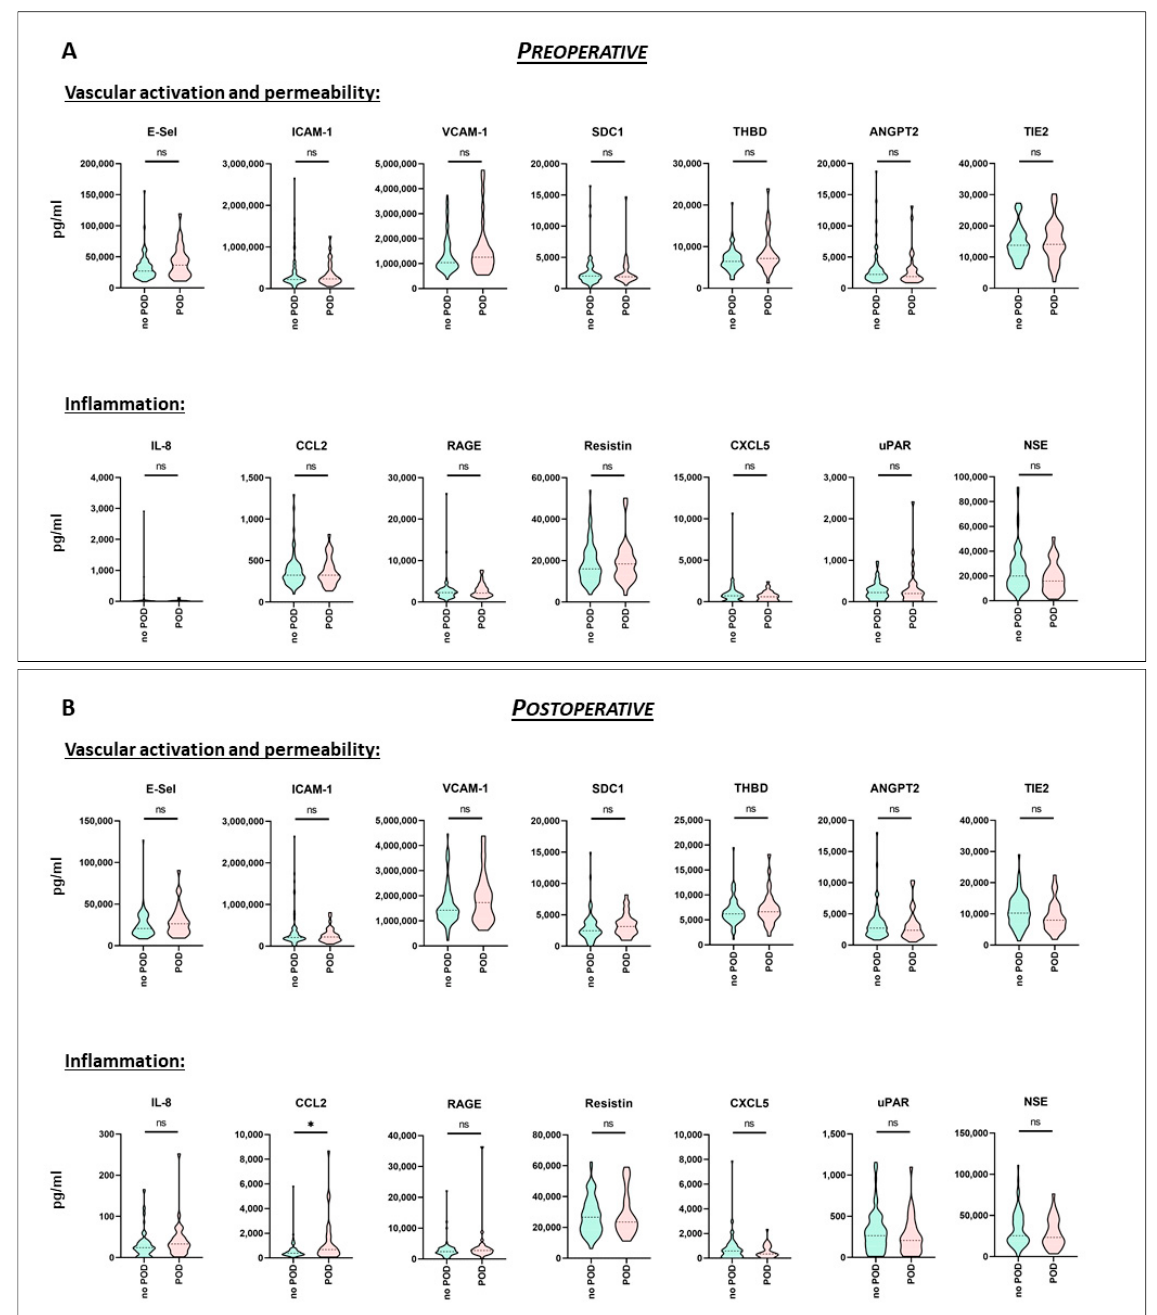
Figure 2. Pre- and postoperative serum biomarker profiling (no-POD and POD). Serum was sampled prior to ( A ) and following surgery ( B ) from a mixed cohort of consecutively recruited elective non-cardiac, as well as cardiac surgery patients. Biomarker profiling was performed using the multiplex array technique. The whole cohort was divided according to development of postoperative delirium (POD). Data are given as median values (black dashed line) with 25th and 75th percentile (white dashed lines) and were compared using the Mann-Whitney U test. no POD: n = 85, POD: n = 33. ns = not significant, * p < 0.05. E-Sel = E-Selectin, ICAM-1 = Intercellular Adhesion Molecule 1, VCAM-1 = Vascular Cell Adhesion Protein 1, SDC1 = Syndecan-1, THBD = Thrombomodulin, ANGPT2 = Angiopoietin-2, TIE2 = Tyrosine Kinase with Immunoglobulin-like and EGF-like domains 2, IL-8 = Interleukin-8, CCL2 = CC-chemokine Ligand 2, RAGE = Receptor for Advanced Glycation Endproducts, CXCL5 = C-X-C Motif Chemokine 5, uPAR = Urokinase Plasminogen Activator Surface Receptor, and NSE = Neuron-specific